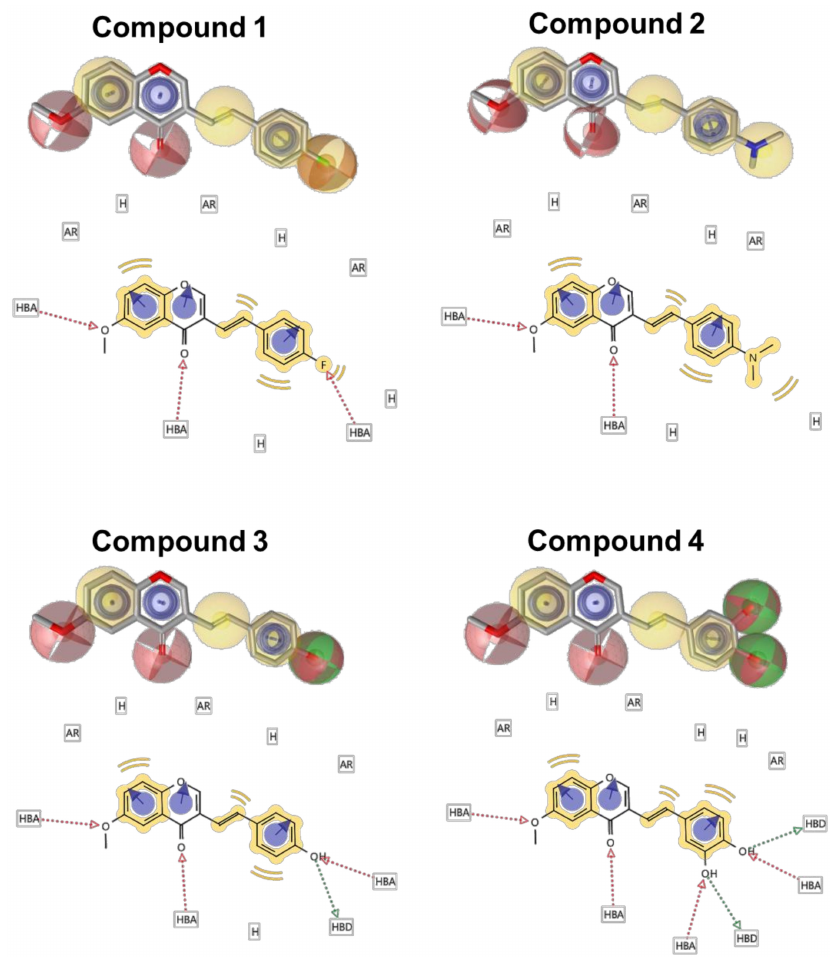
Figure 5. Structural characteristics of four 6M3SC derivatives analyzed by the LigandScout software. The 3D pharmacophore models and 2D characteristics of four 6M3SC compounds were analyzed by the LigandScout software. AR, Aromatic; H, hydrophobic; HBA, hydrogen-bond acceptor; HBD, hydrogen-bond donor. Oxygen and nitrogen atoms are illustrated with red and blue sticks, respectively, and the carbon atoms of these compounds are depicted by gray sticks. Aromatic rings, double bonds, and methoxy groups are illustrated with blue circles, yellow, and green,